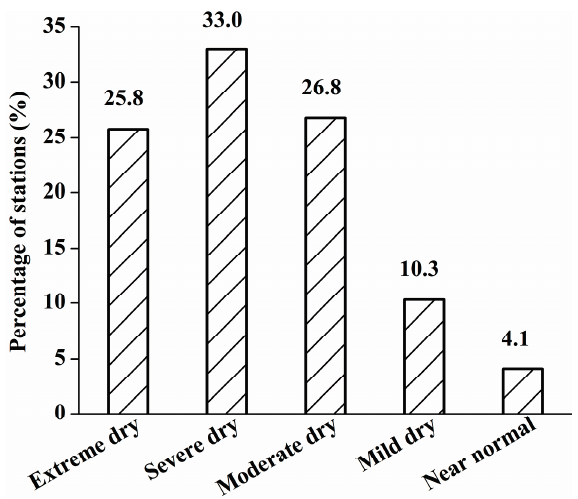
Figure 8. Percentage of precipitation stations on different drought severity levels from April 2008 to December 2009.